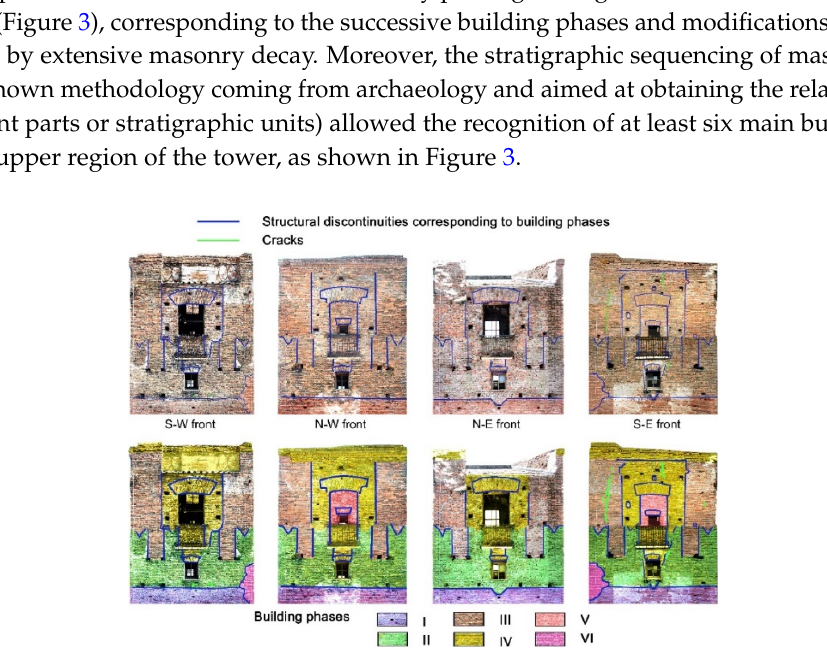
Figure 3. Map of the structural discontinuities observed in the upper part of the Gabbia tower and supposed building phases.